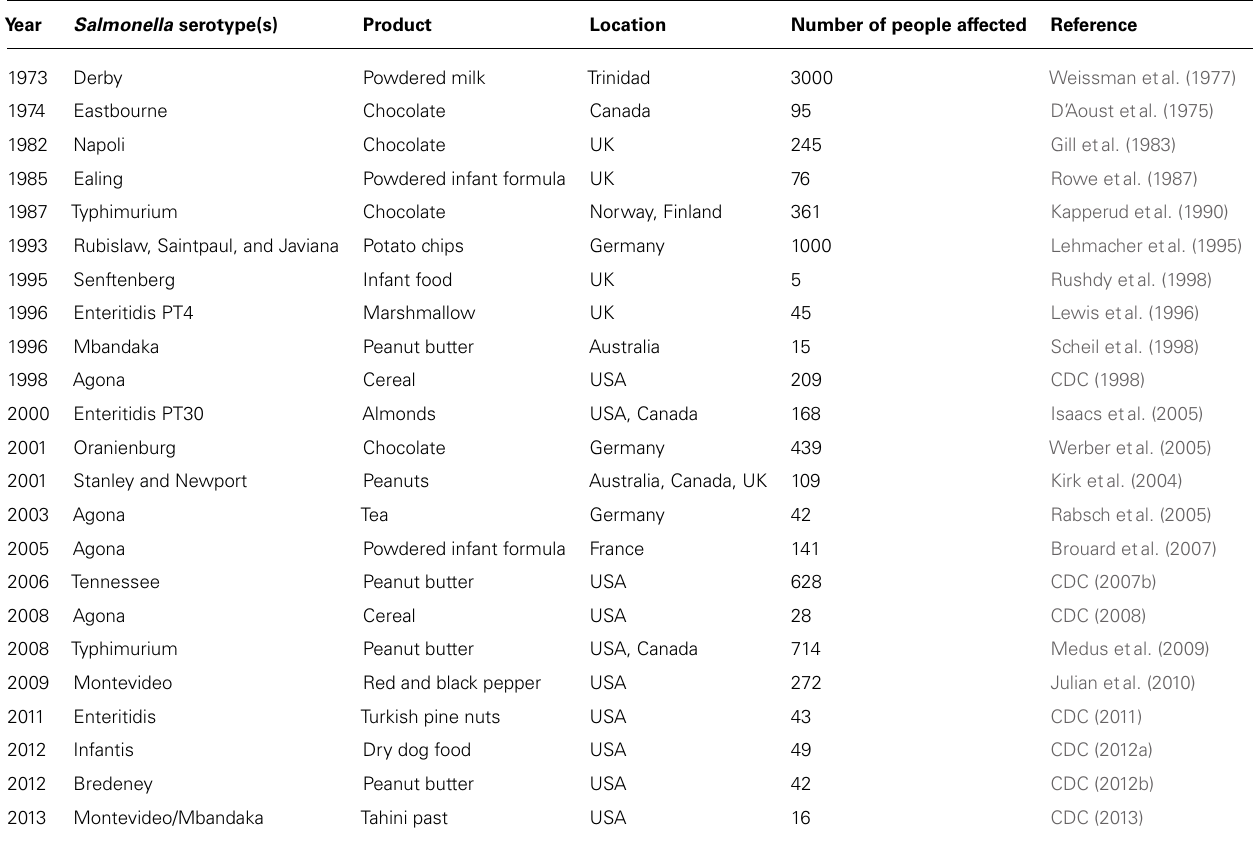
Table 1 | List of selected outbreaks of Salmonella infection after consumption of low-moisture